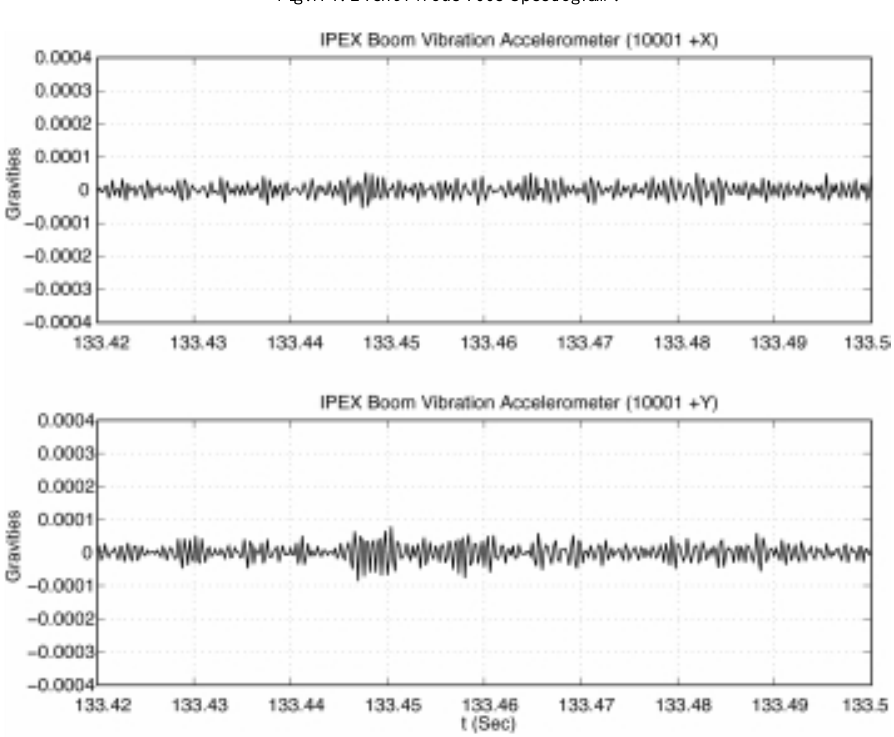
Fig. A5. Event 1 Node